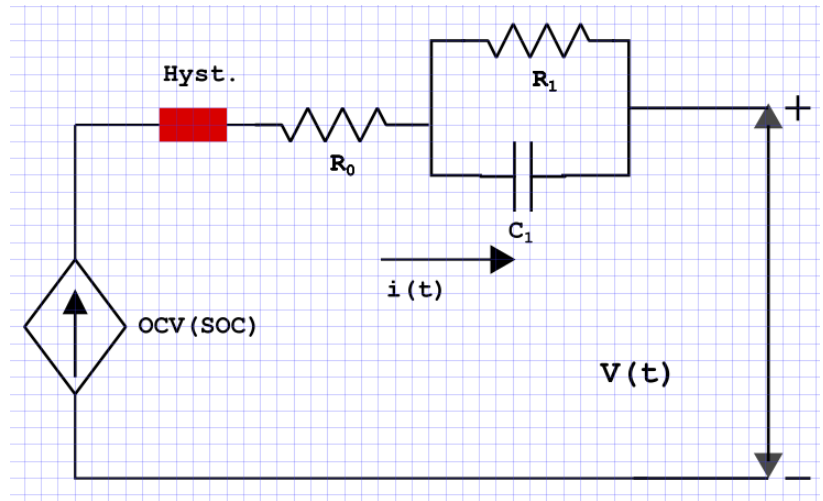
Figure 4. n-RC pair model.